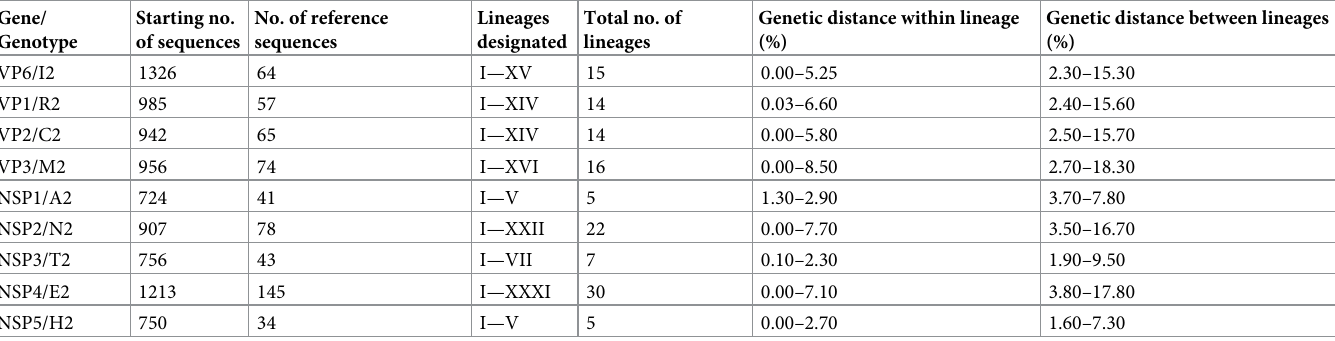
Table 1. Datasets for phylogenetic analysis and average nucleotide sequence divergence within and between lineages of genotype 2 RVA strains. Gene/ Starting no. No. of reference Genotype of sequences